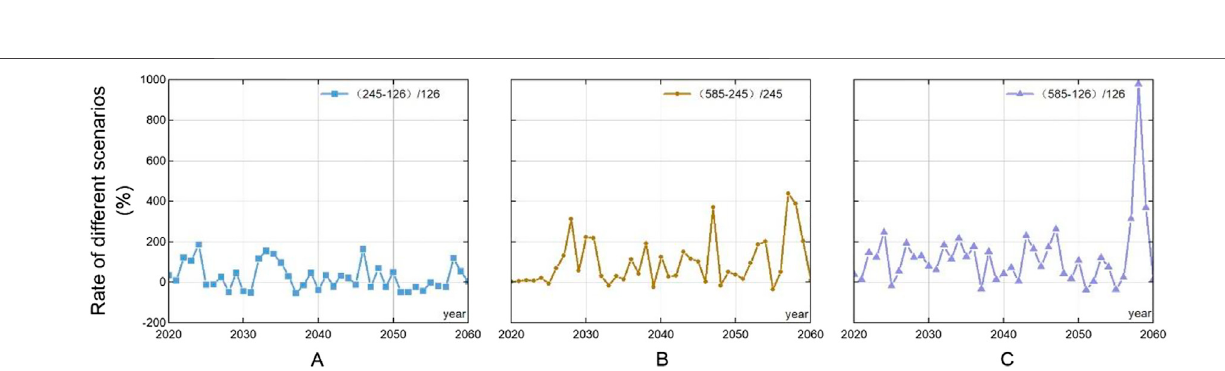
FIGURE 3 | Annual loss ratio curves under three scenarios in Qinghai province from 2020 to 2060. (A) Loss ratio curves under SSP126 scenario;. (B) loss ratio curves under the SSP245 scenario; and (C) loss ratio curves under the SSP585 scenario.